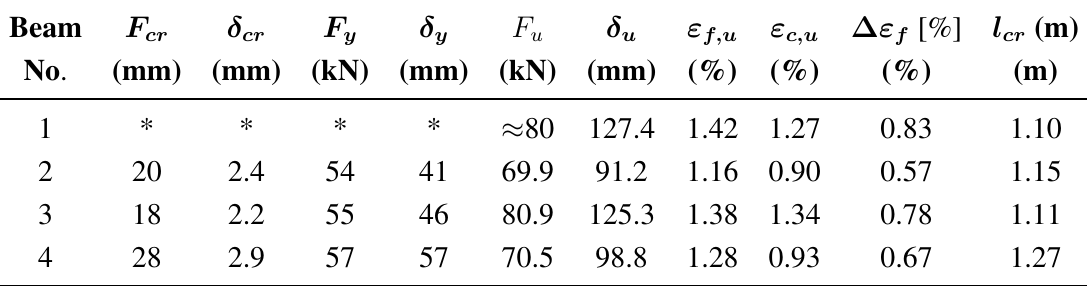
Table 4. Summary of the key results after static loading (* not registered).